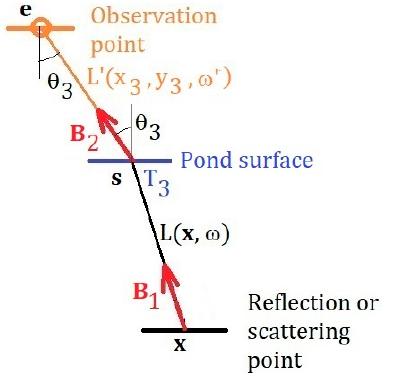
Figure 6. Optical path of light flux above and below the pond surface.